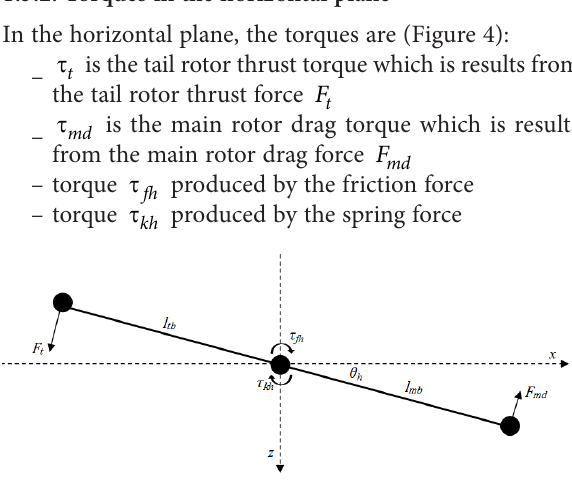
Figure 3. Total forces and torques in the vertical plane Figure 4. Total forces and torques in the horizontal